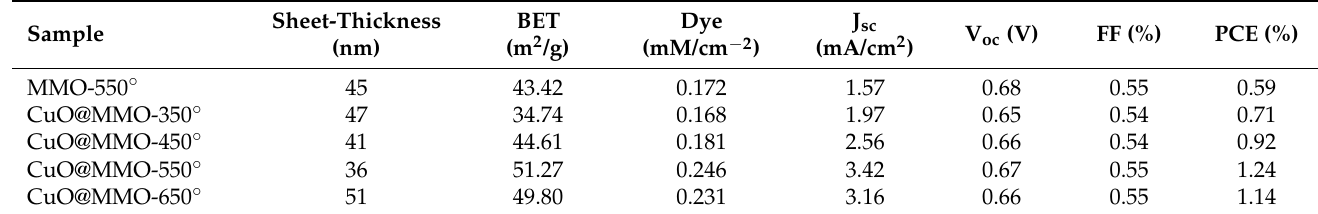
Table 1. In-depth surface and photovoltaic parameters of the fabricated DCCS devices.